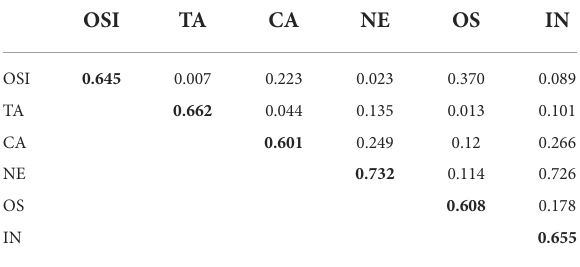
IN 0.655 Main diagonal contains average variance extracted values (AVE). Squared correlations betweentheconstructsareabovethemaindiagonal.